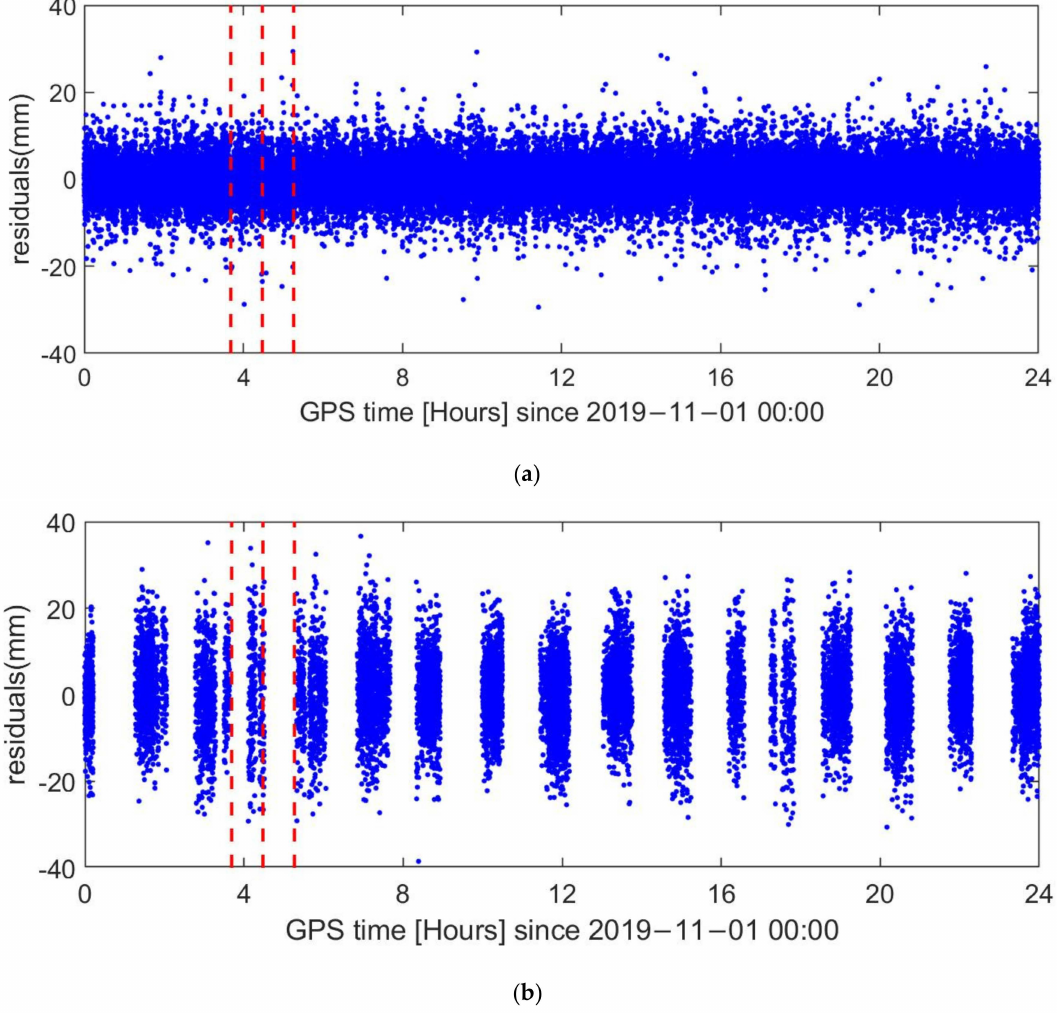
Figure 14. Double-difference ionospheric-free phase residuals on DOY 305 in 2019; the red dashed lines indicate the center of burn time: ( a ) GPS satellites; ( b ) BDS2